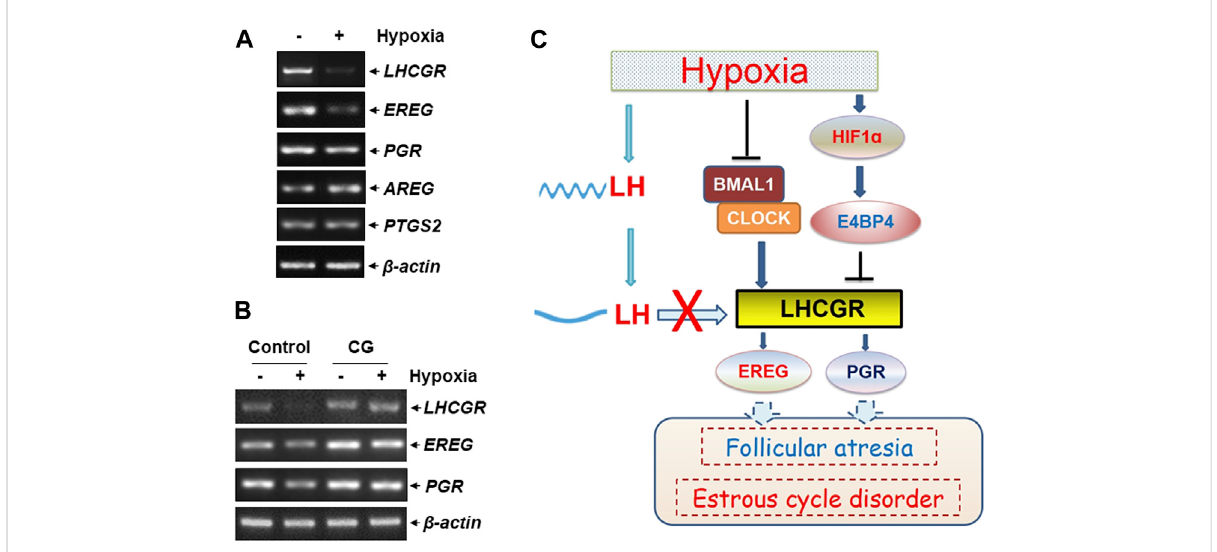
FIGURE 6 LHCGRagonistrestoredtheimpairedovulation-relatedgeneexpressioninthegranulosacellsinducedbyhypoxia. (A) KK1cellswereuntreated or exposed to hypoxia. The expression levels of LHCGR and the ovulation-related genes were detected. (B) KK1 cells were untreated or exposed to hypoxia with or without pretreatment of CG. The expression levels of LHCGR and the ovulation-related genes were detected. (C) Working model of circadian clock-controlled female reproductive dysfunction upon hypoxic